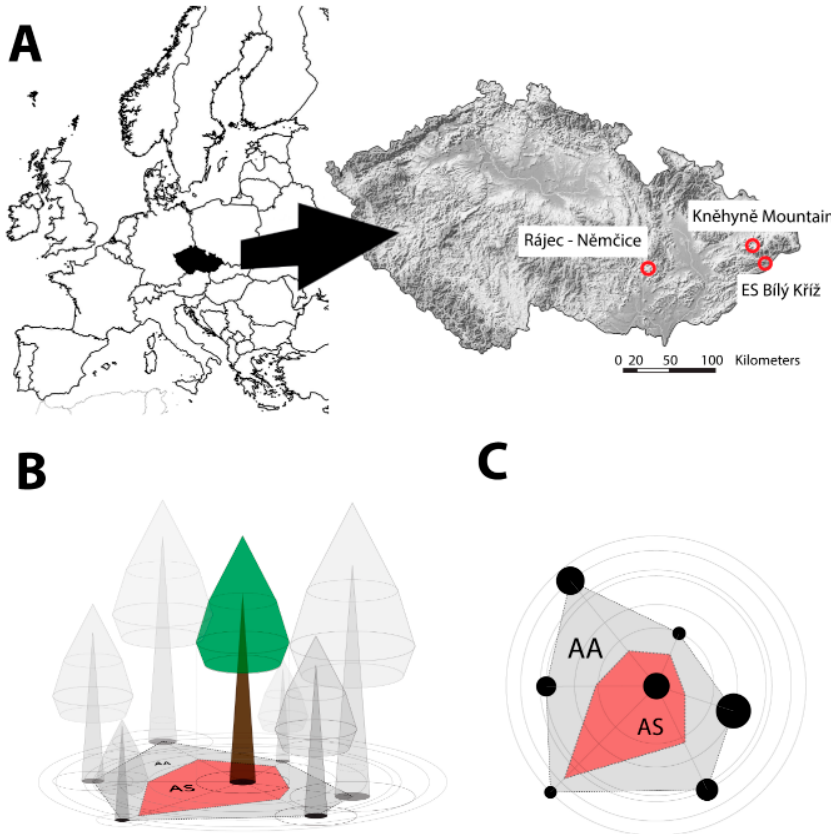
Figure 1. Geographic location of the 3 study sites in the Czech Republic ( A ). An example of three dimensional ( B ) and two dimensional ( C ) spatial representation of a sample tree and the closest neighboring trees with spatially-available area (AA) marked with a light grey and social area (AS) marked with a dashed line and light red.